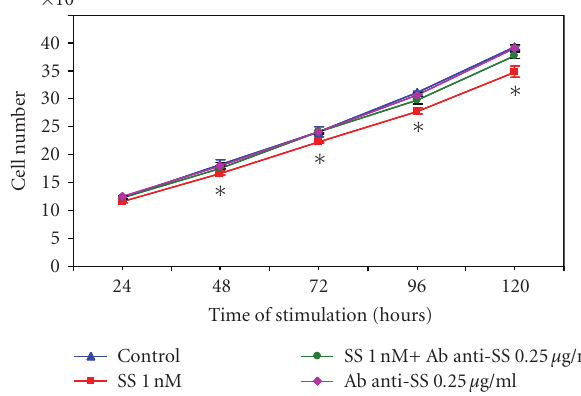
Figure 4: Growth control of the RIN-14B cells by somatostatin and a specific somatostatin antibody. Cells were grown for up to 120 hours in the presence of 1nM somatostatin (SS) ± 0.25 μ g mL − 1 of SS antibody (Ab anti-SS) or Ab anti-SS alone. Medium and drugs were changed daily and cells were counted daily for up to 5 days. Results are the means ± SE of 5 wells per point in each group. ∗ Significantly di ff erent than control at P < .